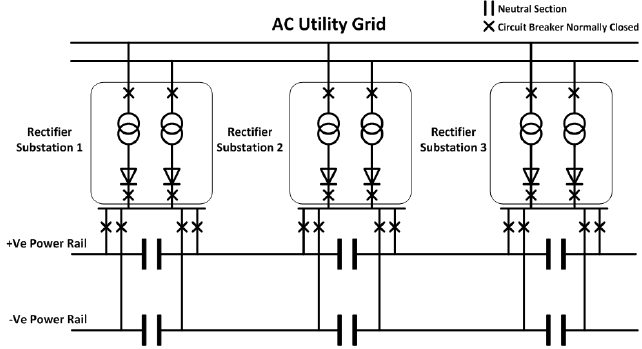
Figure 4. Configuration of the DC railway power system of a single track.